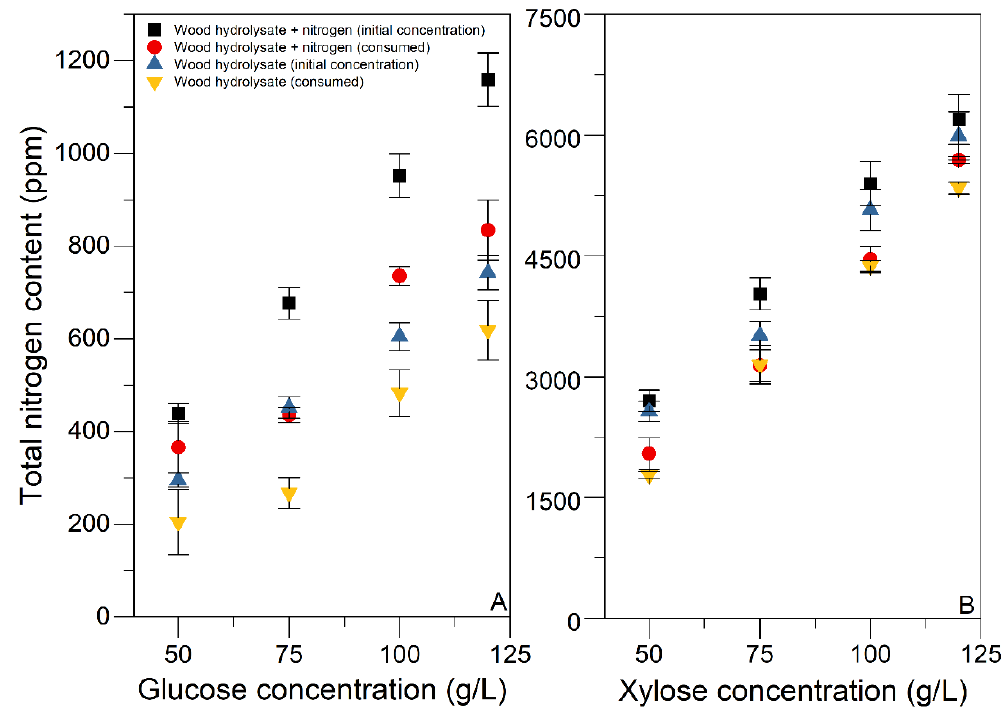
Figure 3. Total nitrogen consumption by R. toruloides -1588 using wood hydrolysate as culture media. ( A ) C6 hydrolysate; ( B ) C5 hydrolysate. Table 1. Performance of R. toruloides -1588 using C5 and C6 hydrolysates as a culture